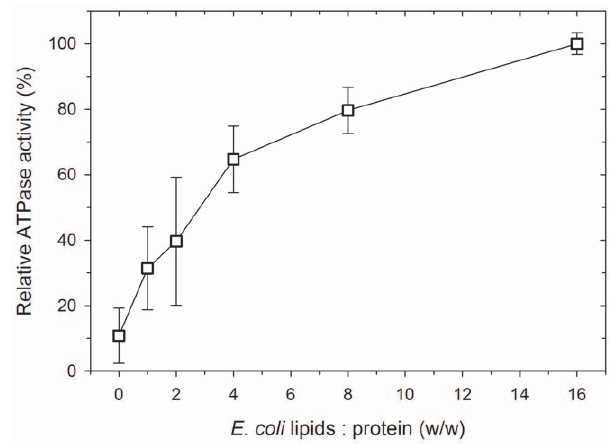
Figure 7. Lipid dependence of ATPase activity. ATP hydrolysis of Opti-Pgp was assayed after activation with increasing concentrations of E. coli lipids as described in Materials and Methods. Averages 6 range of two independent experiments are given. 1% lipids added correspond to a lipid: protein ratio of 16:1.